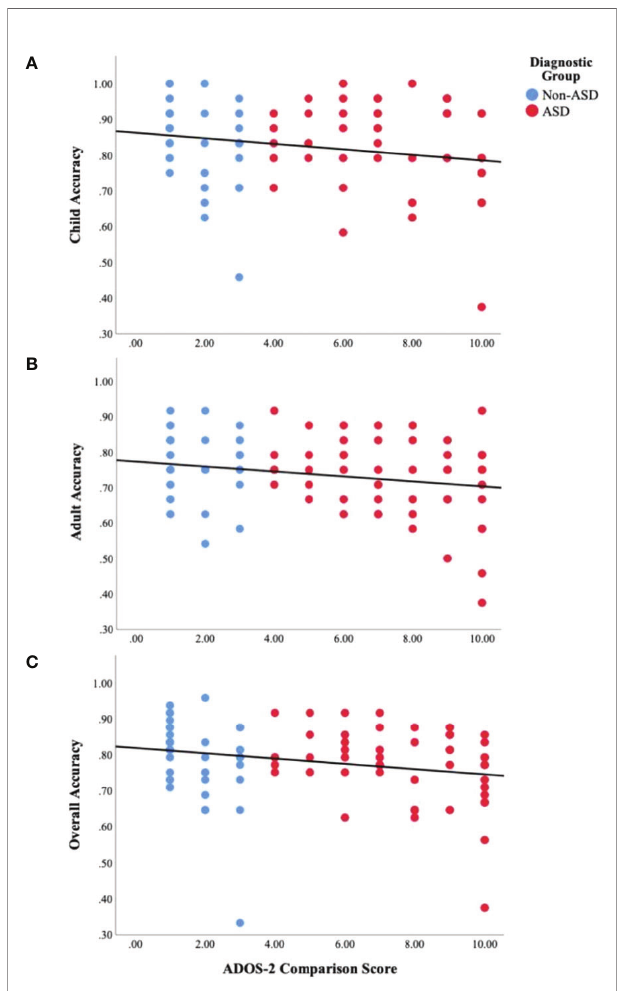
FIGURE 4 | Scatter plots displaying the relationship between ASD symptom severity, as measured by the ADOS-2 Comparison Scores, and behavioral facial emotion recognition accuracy on the (A) child subtest ( r (90) = − .21, p =.04), (B) adult subtest ( r (90) = − .20, p =.06), and (C) overall task ( r (90) = − .23, p